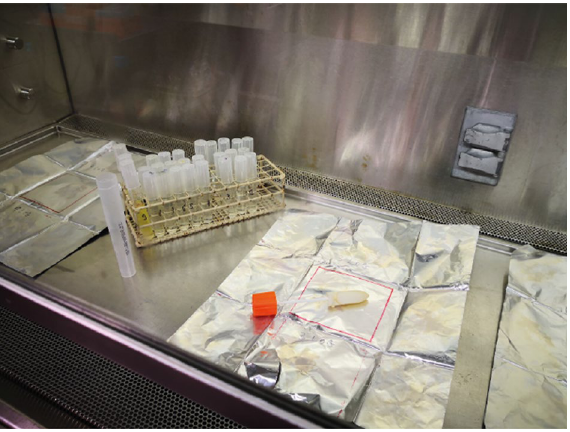
Figure 1. Sampling procedure performed on simulated bench working surface. Sampling procedure performed on simulated bench working surface (alumina foil). The alumina foil was been contaminated with LM cultures, following the procedure described in the “Materials and methods”